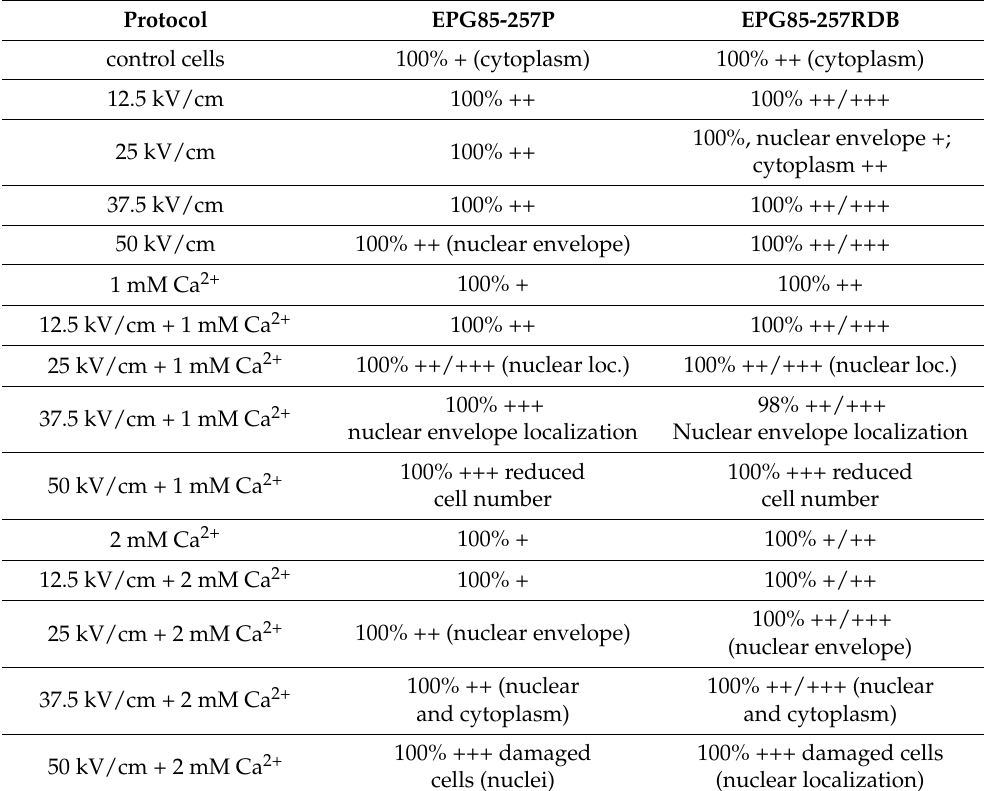
Table 1. Immunocytochemical evaluation of AIF (apoptosis inducing factor) in gastric cancer cells after nsPEFs therapy with calcium